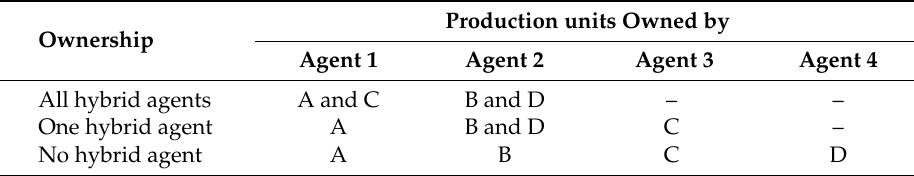
Table 5. Case study: ownership structure. A: power units at buses 1–3 and 12. B: power units